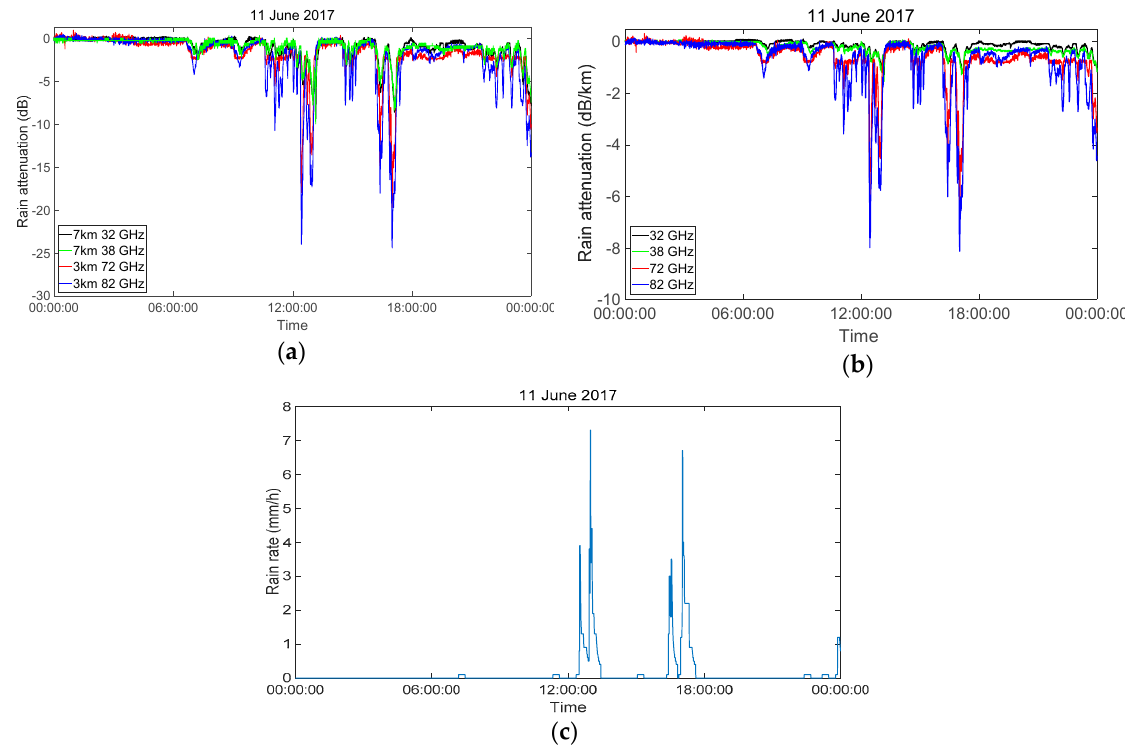
Figure 5. ( a ) Received signal variation of the test links on June 11, 2017. ( b ) Received signal variation of the test links averaged over 1 km distance. ( c ) Rain rate monitored by a rain gauge.